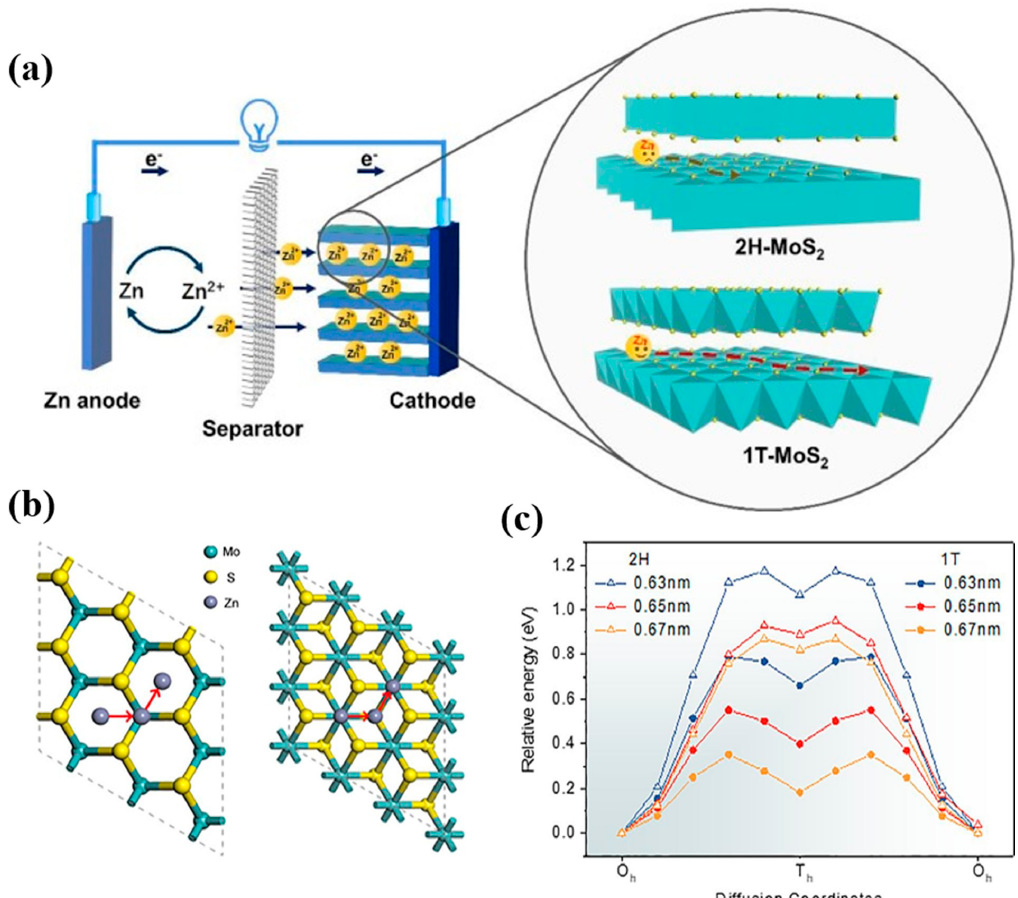
Figure 14. ( a ) Schematic of a rechargeable MoS 2 cathode with different phases (1T- and 2H-MoS 2 ). ( b ) The adsorption sites and diffusion pathway of Zn 2+ (left:2H phase MoS 2 and right: 1T phase MoS 2 ). ( c ) Calculation of Zn 2+ diffusion energy barrier on the1T and 2H phases. Reprinted with permission from Liu et al. [75] Copyright 2020, Elsevier B.V.